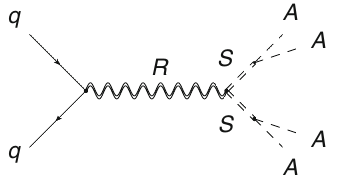
Fig. 2 Sample diagram for a R → SS signal